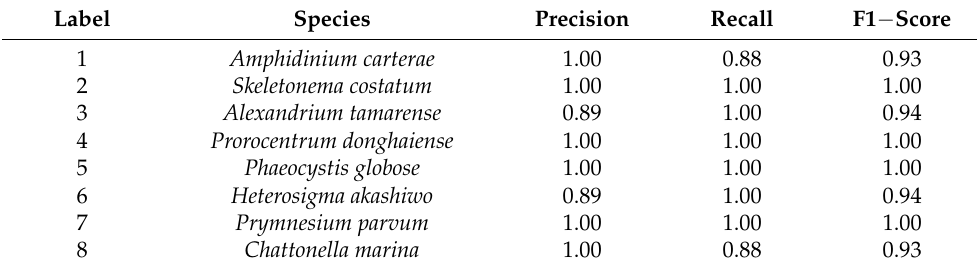
Table 5. Precision , recall , and f1 − score of test samples of eight species of algae.